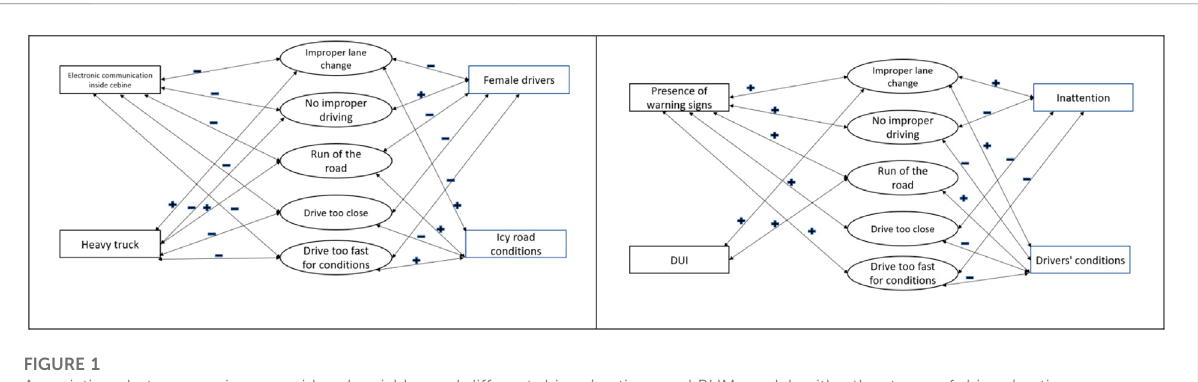
Frontiers in Built